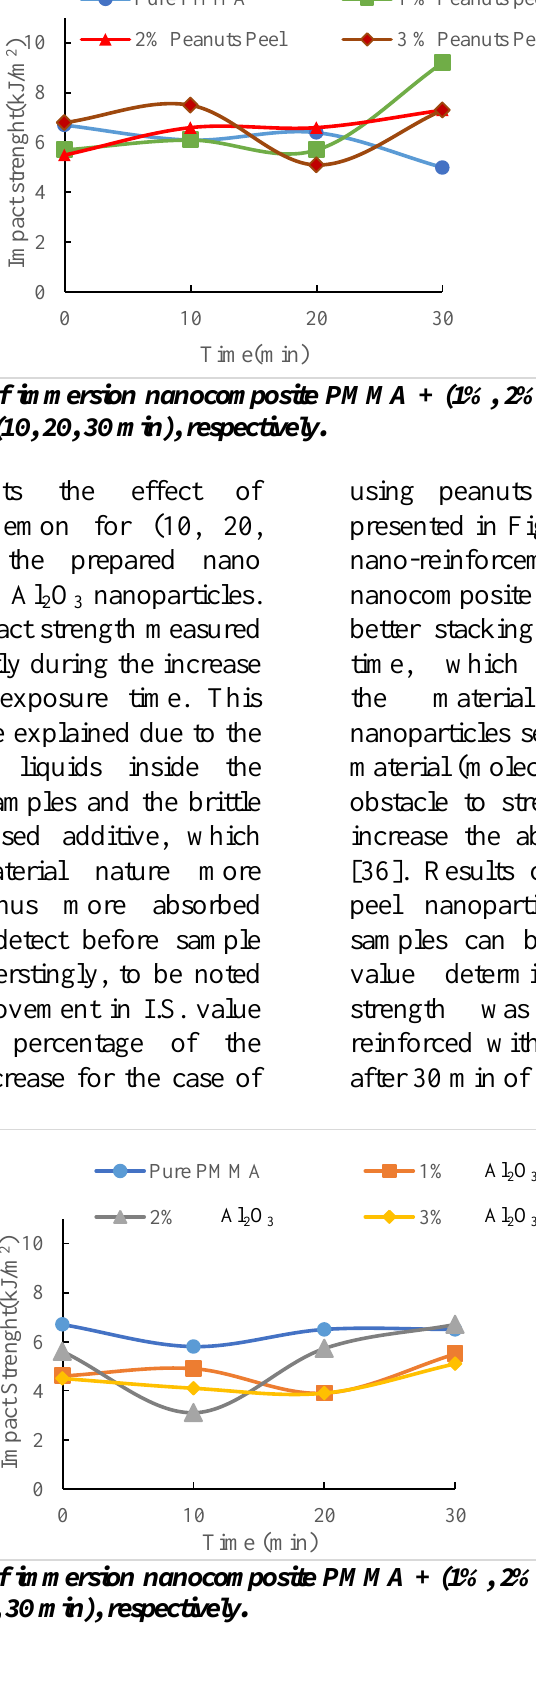
O ) in natural 2 3